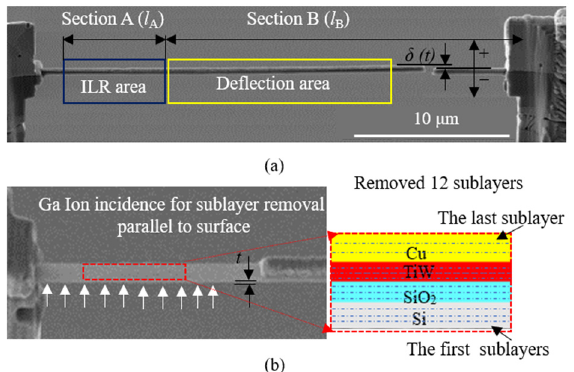
Figure 1. Schematic diagram of the TSV sample: ( a ) the TSV-Cu array; ( b ) cross-section of TSV-Cu; ( c ) polished axial cross-section of TSV-Cu.